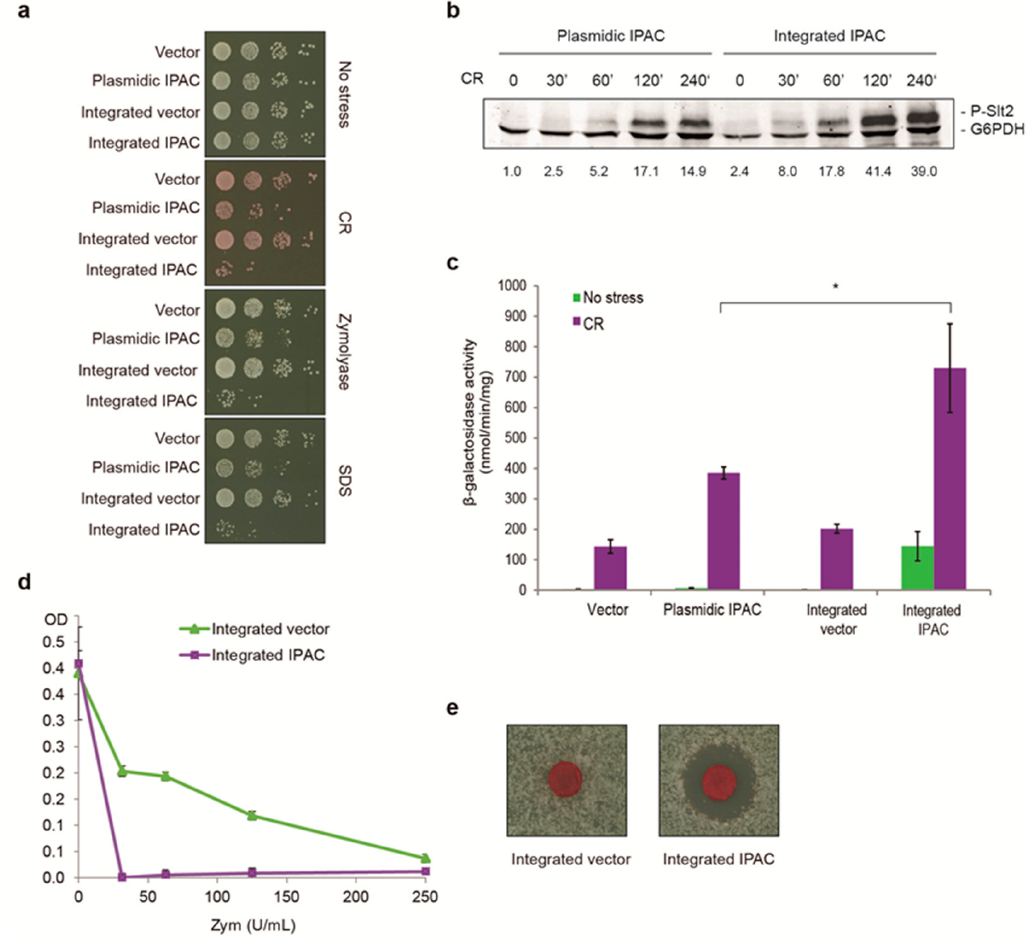
Figure 1. Integration of IPAC results in greater CWI pathway hyperactivation than the IPAC-bearing plasmid. ( a ) Sensitivity to different stresses of BY4741 strain bearing either the empty vector YC- plac111 or the plasmid YCplac111-IPAC, and control wild type with the integrated vector (YSTH1) or with integrated IPAC (YSTH2). Ten-fold serial dilutions of cell suspensions were spotted onto YPD plates in the absence (no stress) or presence of 5 µ g/mL CR, 10 U/mL (100 µ g/mL) zymolyase 100T, or 100 µ g/mL SDS. A representative assay from three different experiments with distinct transformants is shown. ( b ) Western blotting analysis of extracts from BY4741 strain transformed with plasmid YCplac111-IPAC or the YSTH2 strain (integrated IPAC) treated with 30 µ g/mL CR for the indicated times (min). Dually phosphorylated Slt2 and G6PDH (as a loading control) were detected with anti-phospho-p44/42 and anti-G6PDH antibodies, respectively. The numbers below correspond to the amount of phosphorylated Slt2, normalized with respect to the loading control for each sample and expressed as a fold increase relative to the basal phosphorylation levels in the absence of stress of BY4741 cells bearing the YCplac111-IPAC plasmid. A representative blot from three independent experiments is shown. ( c ) β -galactosidase activity of cell extracts from the same strains as in ( a ), all bearing the MLP1 p- lacZ plasmid. Cells were either left untreated (no stress) or treated for 4 h with 30 µ g/mL CR. Data represent the mean of β -galactosidase activity of three independent transformants. Error bars indicate standard deviation, and an asterisk indicates statistical significance relative to plasmidic IPAC according to Student’s t -test (* = p -value < 0.05). ( d ) Multiwell plate sensitivity assay of the YSTH1 strain (integrated vector) and the YSTH2 strain (integrated IPAC) to the indicated concentrations of zymolyase 100T. Data represent the mean of three independent transformants. Error bars indicate standard deviation. ( e ) Halo sensitivity assay of the same strains as in ( d ). Disks were impregnated with 10 mg/mL CR. A representative assay from three different experiments is